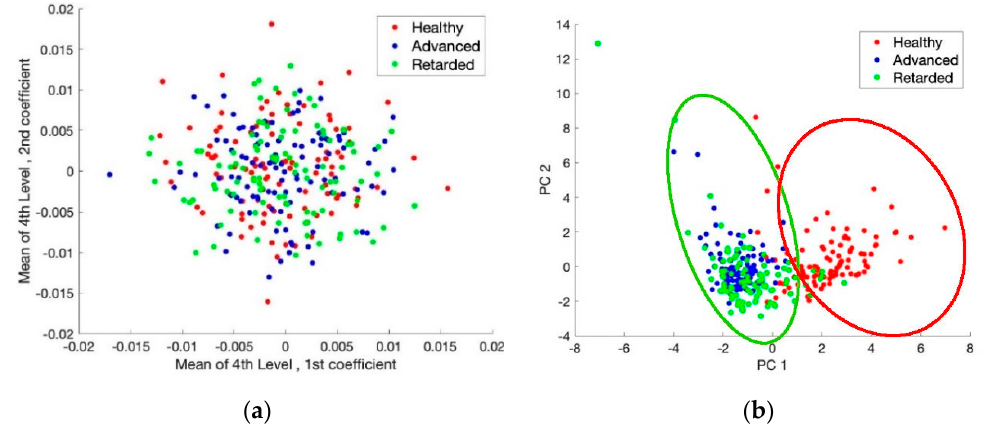
Figure 5. Feature space of: ( a ) an existing feature set (Mean of Coefficient 1 vs. Mean of Coefficient 2); and ( b ) the first two principle components (PC1 vs. PC2).